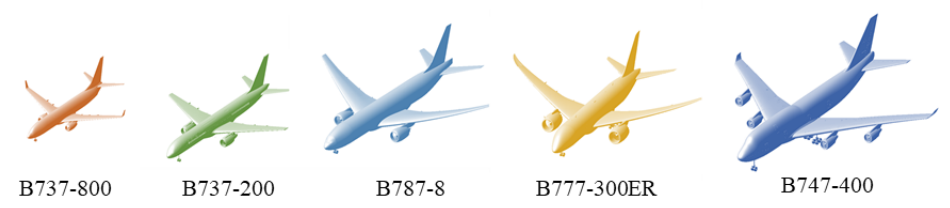
Figure 3. Virtual prototype models of typical Boeing aircraft assembled in ADAMS/Aircraft. Using the B787-800 as an example [17], Table 2 shows the parameters used for the fuselage, landing gear, and wheel. The stiffness and damping ability of the landing gear system were considered using landing gear buffer model. Detailed information about landing gear buffer model can be found in authors’ previous publication [10]. Table 2. Virtual prototype model of B787-800 and parameters